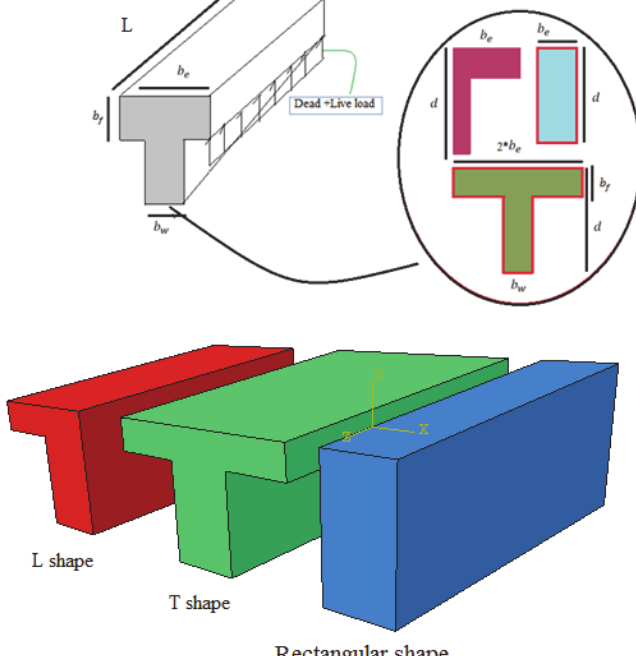
Figure 1: Schematic figure of the L, T, and Rectangular sections